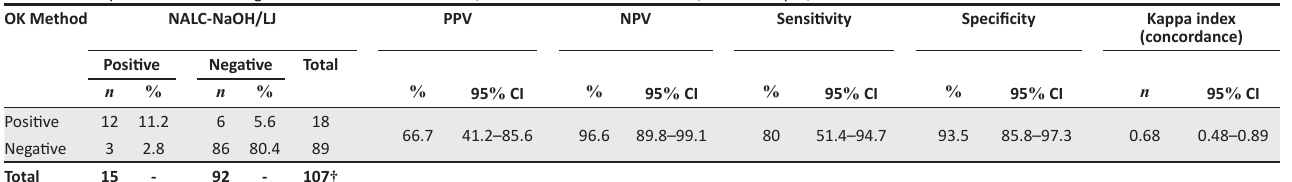
TABLE 1: Comparison between Ogawa-Kudoh and NALC-NaOH/Lowenstein Jensen methods, Mozambique, 2014. OK Method